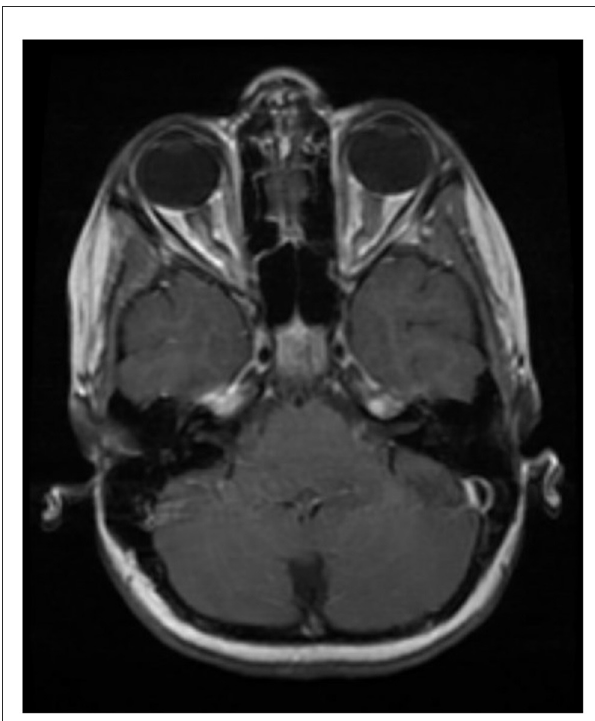
FIGURE1 Typical optic nerve involvement in MOGAD. Bilateral and longer lesions involving anterior parts of the optic nerve.